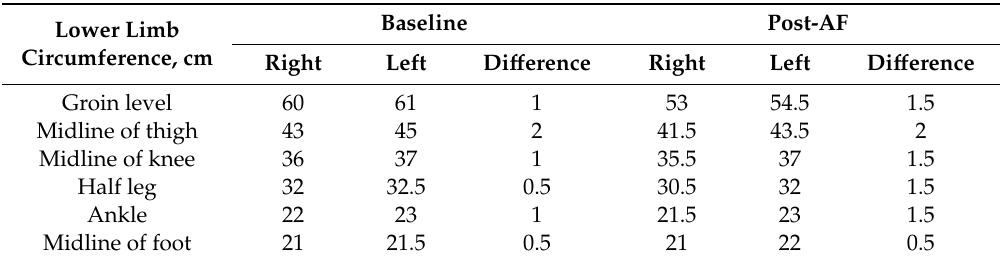
Table 3. Measurements of lower limb circumference at several anatomical points at baseline and after adapted fitness (AF). Lower Limb Circumference, cm